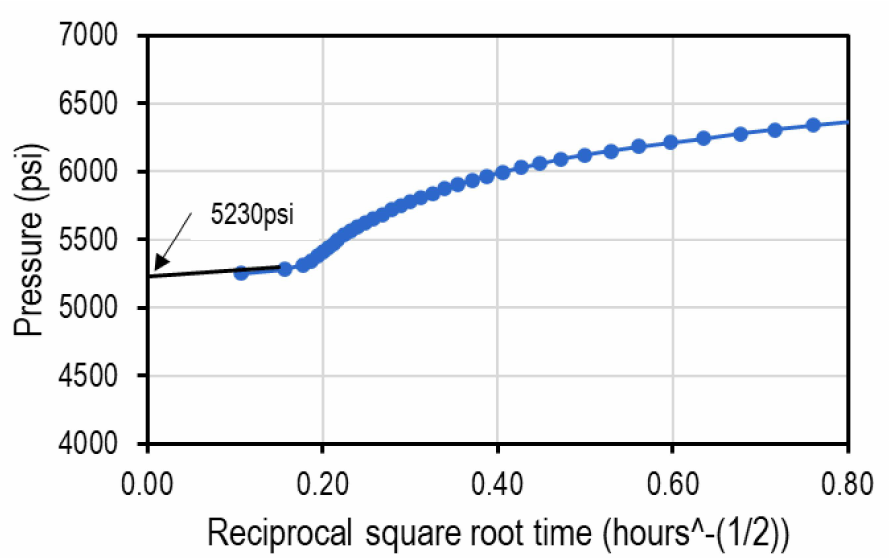
Figure 13. Post-closure reciprocal square root time for estimating pore pressure Well